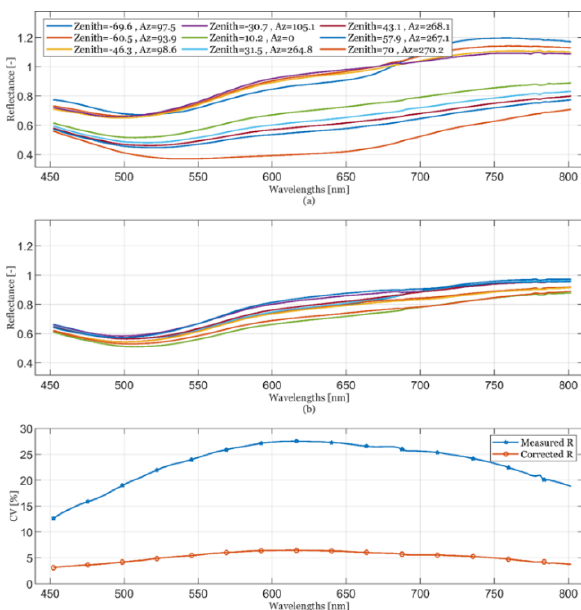
Figure 8 . The reflectance values of the Light Soil ROI before correction (a), after correction (b), and the statistics CV of reflectance values at different zenith angles